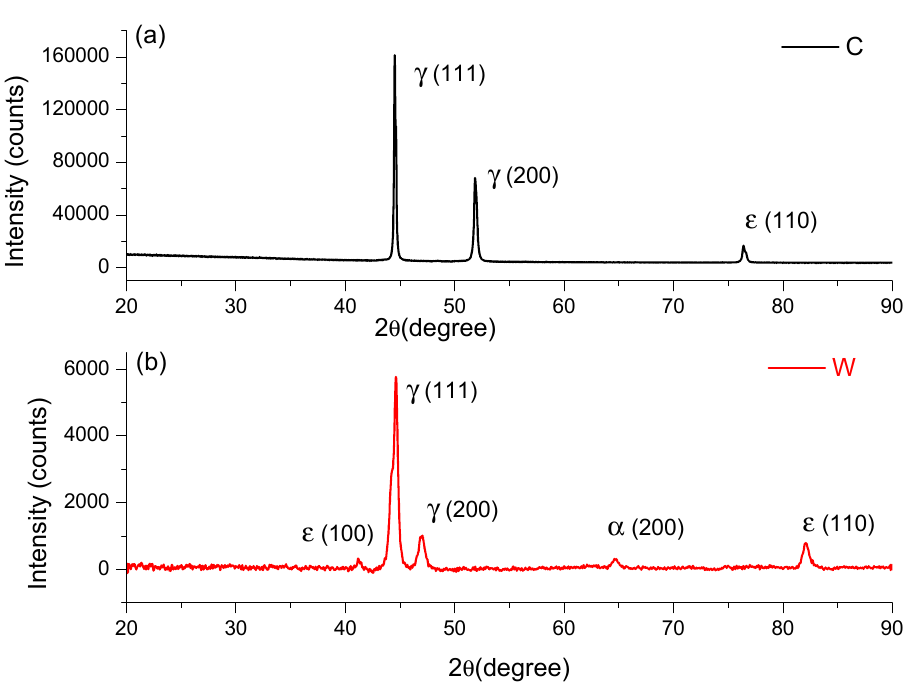
Figure 1. XRD spectra of FeMnSi: ( a ) cast and ( b ) wrought.